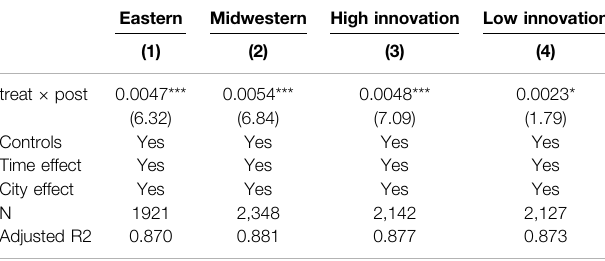
TABLE 8 | Heterogeneity analysis test